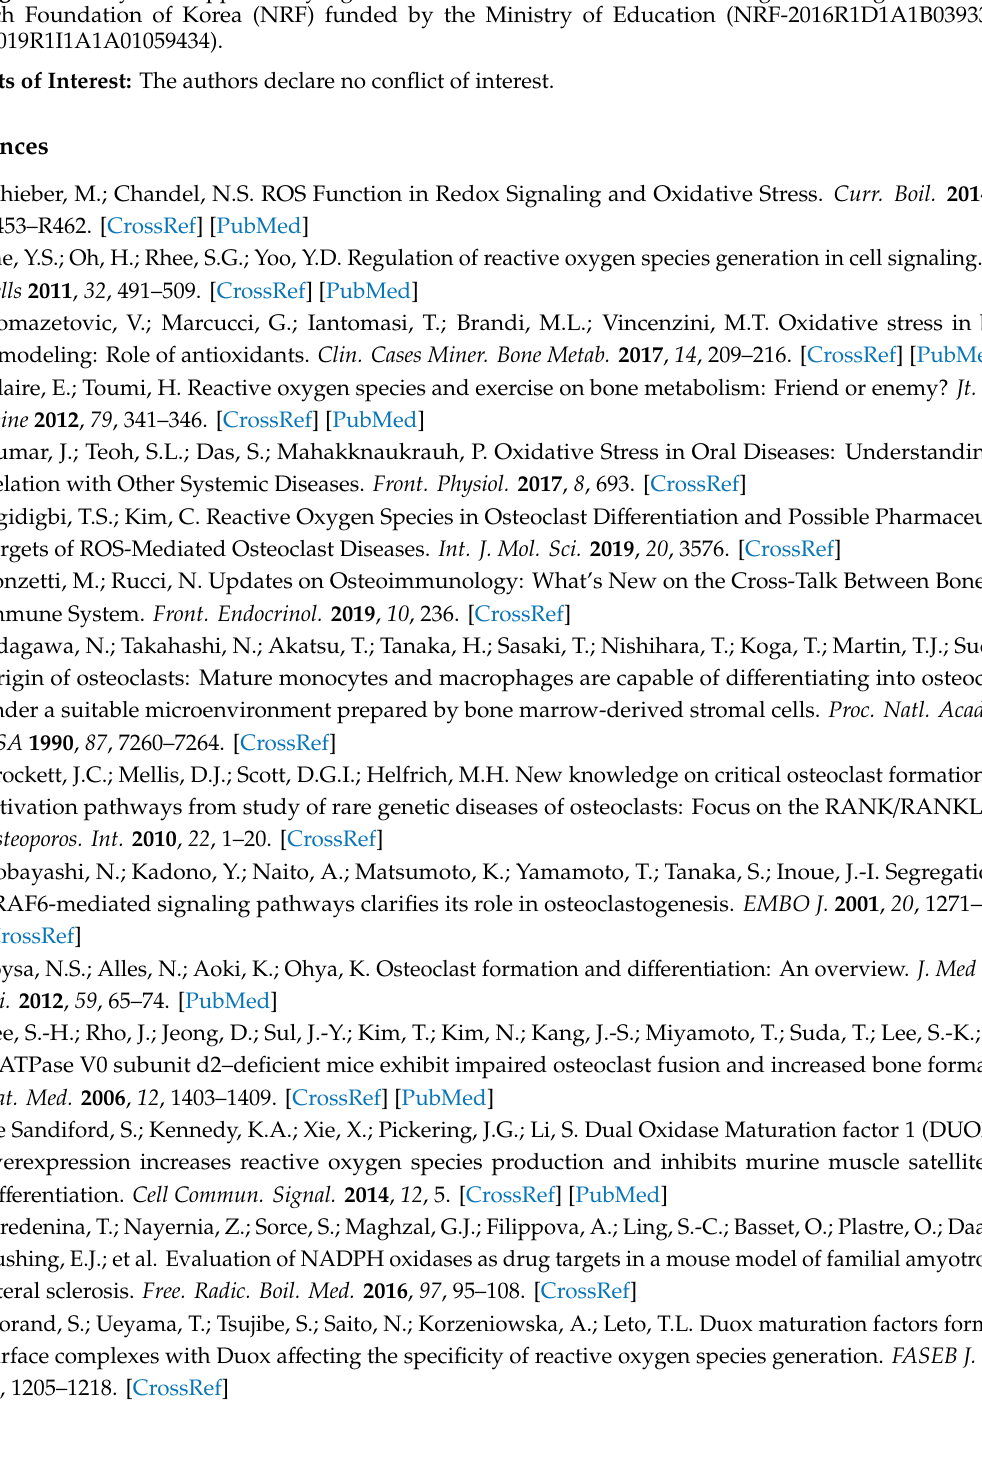
Figure S1: BMMs were transfected with siControl or siDuoxa1 using lipofectamin3000, and cultured in the presence of M-CSF (30 ng / mL) for 3 days. Cell viability was analyzed by an XTT assay. Figure S2: Overexpression of Duoxa1 increases RANKL-induced ROS